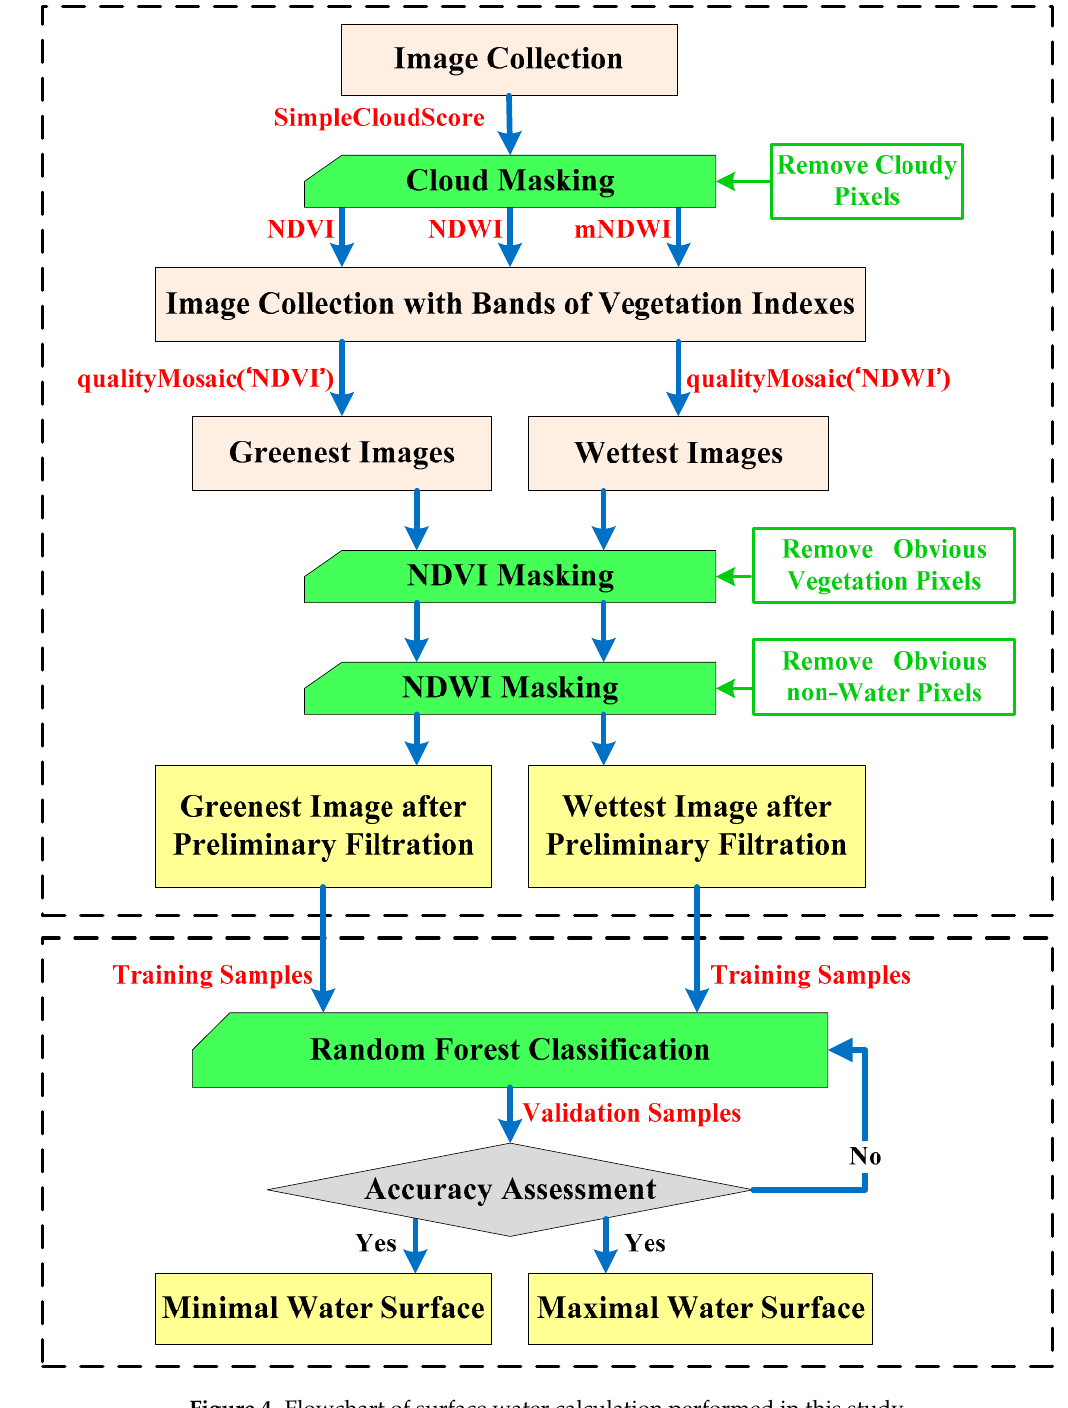
Figure 4. Flowchart of surface water calculation performed in this study.